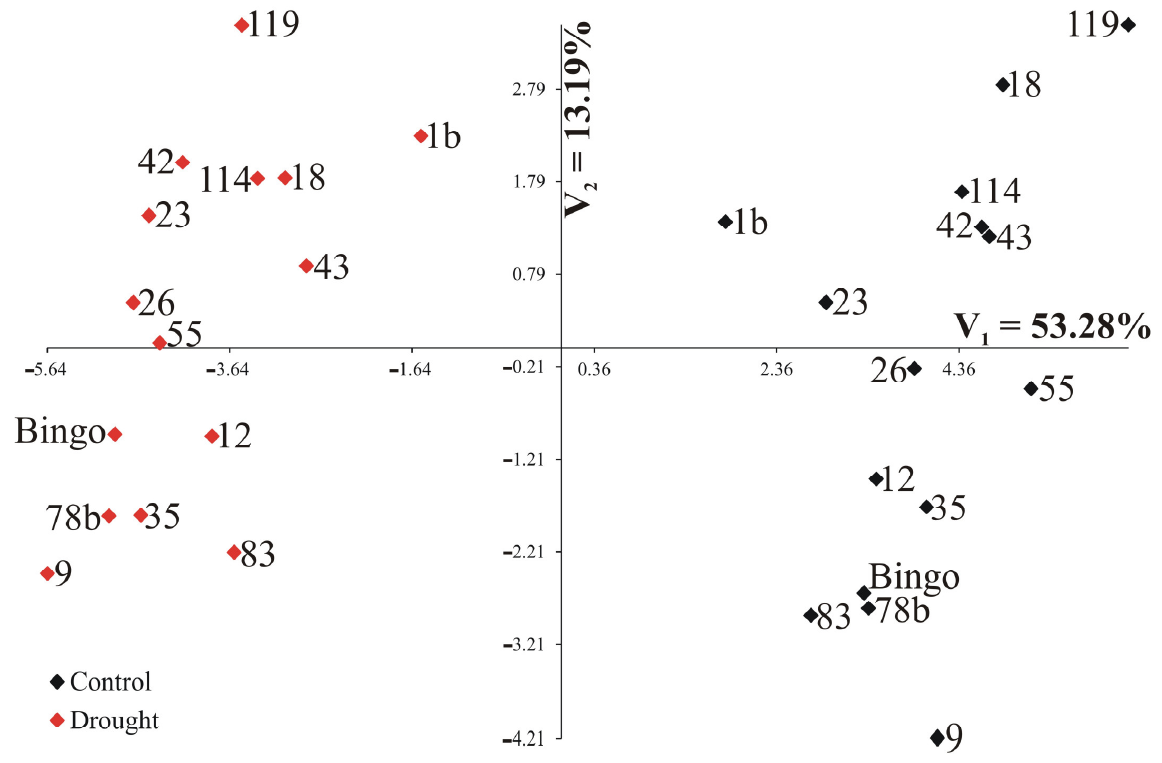
Figure 5. Distribution of 15 genotypes in the space of the first two canonical variables for both treatments: control and drought.